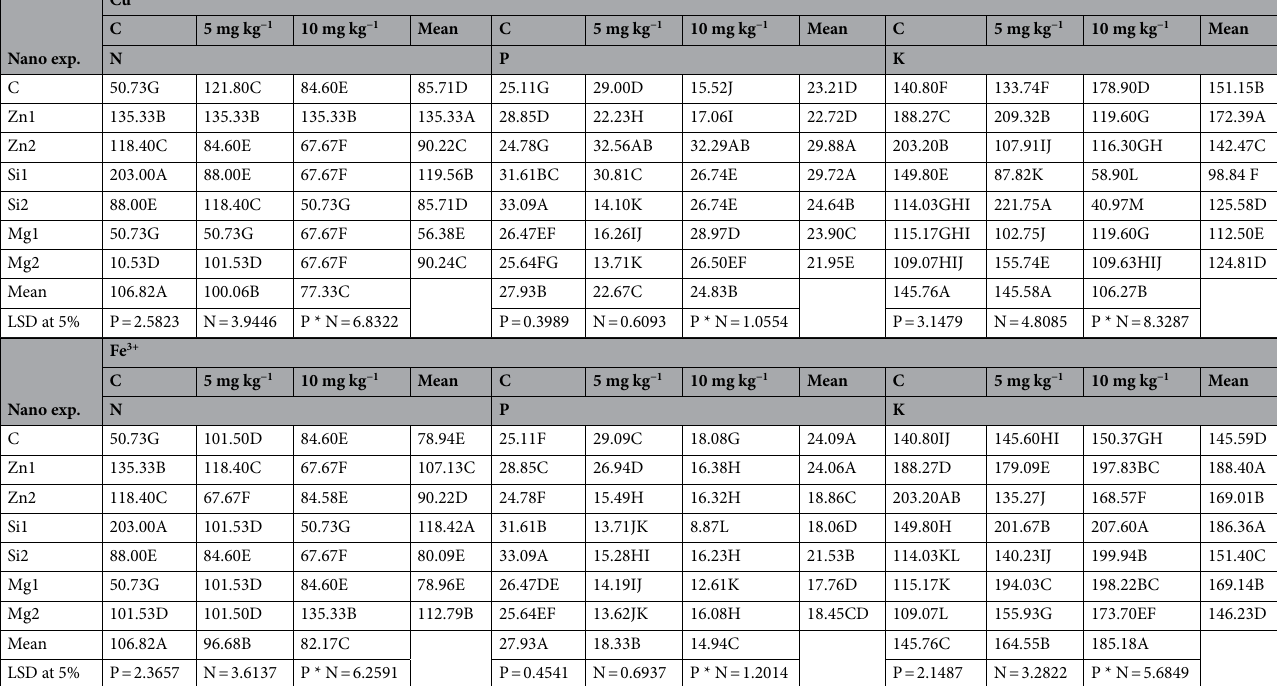
Table 5. Effect of polluted water containing Cu 2+ and Fe 3+ and different NPs on the availability and accumulation of N, P, and K in the treated